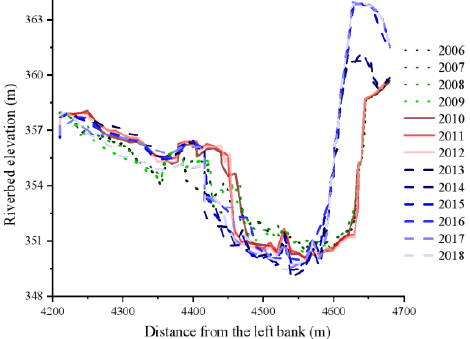
Figure 3. 2006 – 2018 Lintong station post − flood cross −